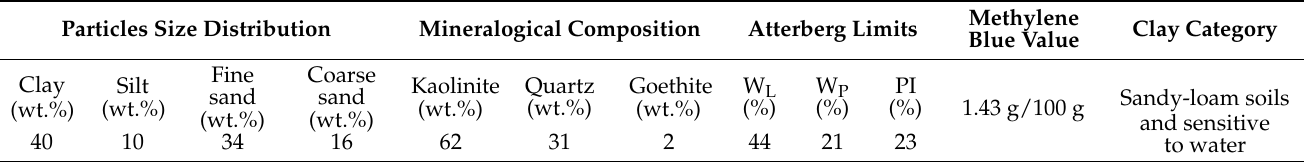
Table 1. Geotechnical and mineralogical composition of raw soil